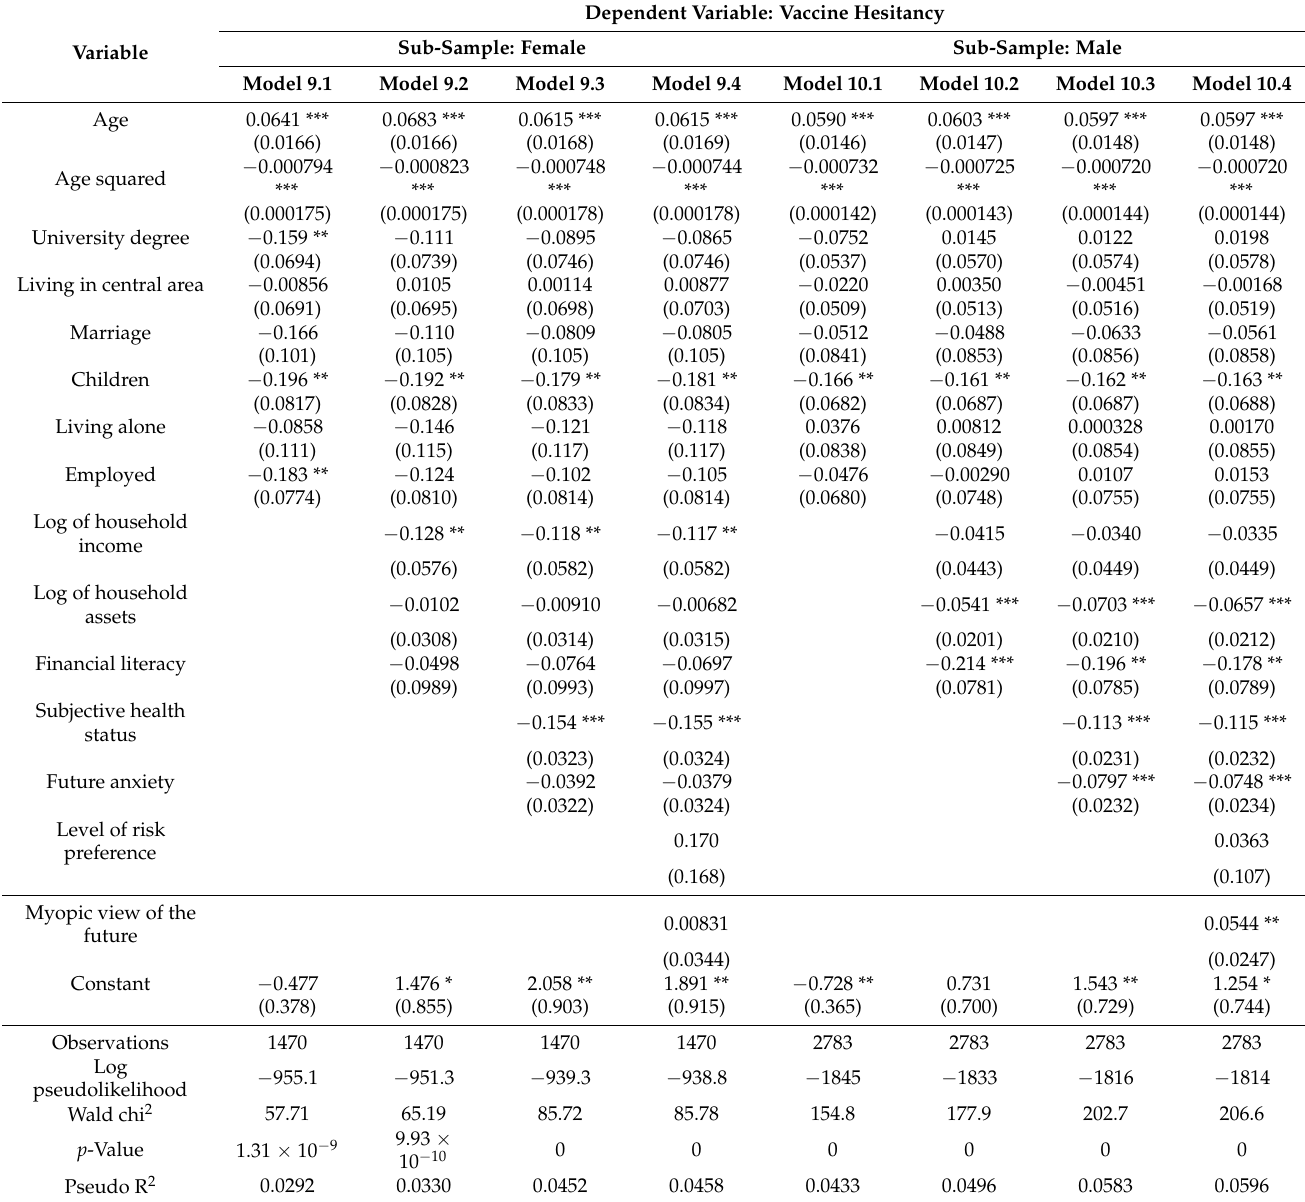
Table 10. Probit model regression results (subsample analysis: